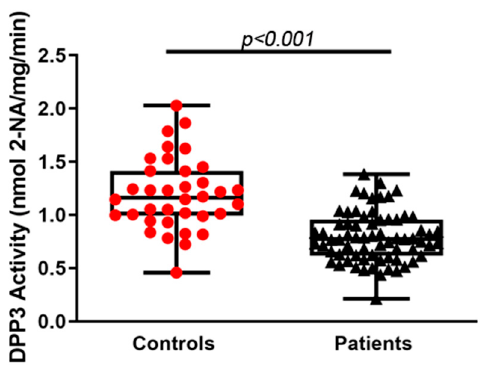
Figure 1. DPP3 activity in the serum of controls ( n = 36) and postmenopausal women with severe osteoporosis ( n = 69) at baseline. Statistical significance was calculated using two-tailed Mann–Whitney test; **** p < 0.0001.